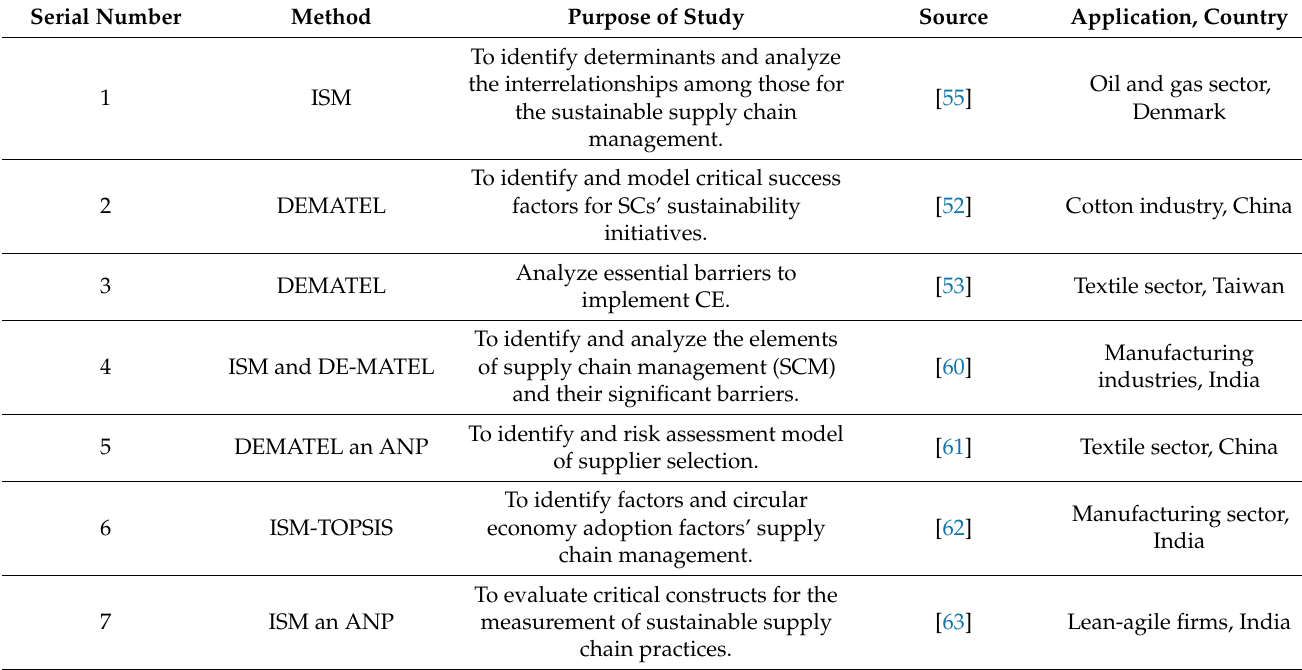
Table 3. ISM and DEMATEL applications in the supply chain and textile